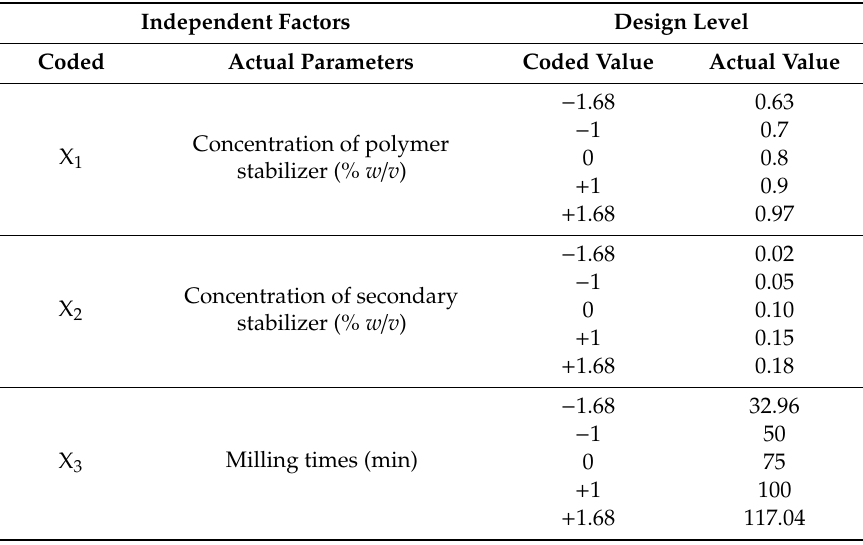
Table 1. Independent factors and their levels in central composite